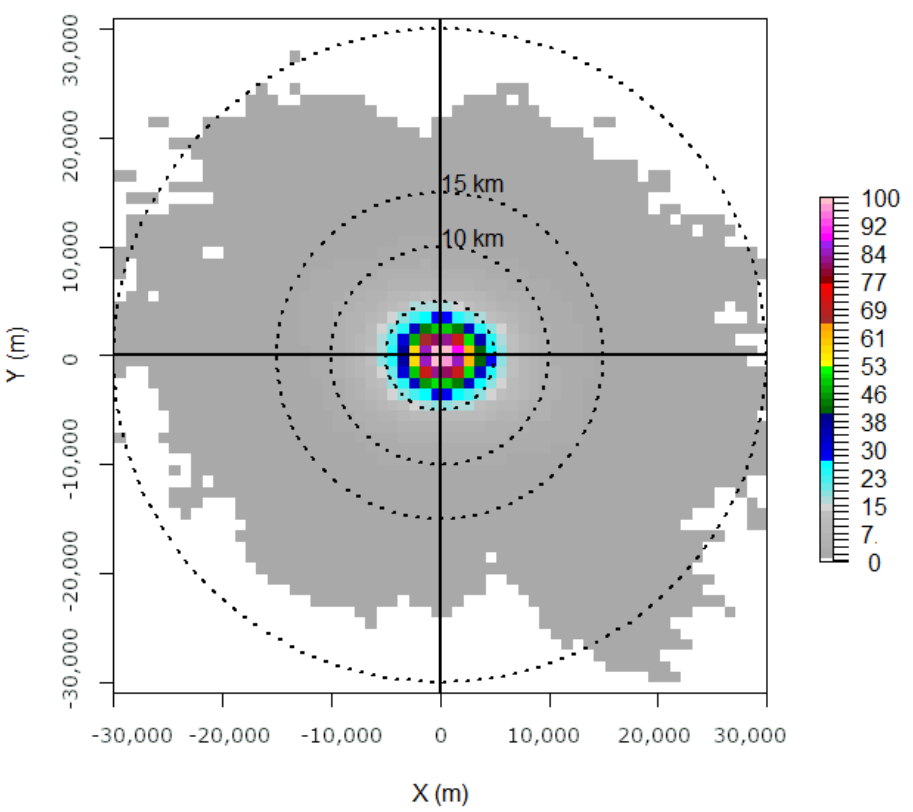
Figure 7. The probability of occurrence of hail is based on the 2196 cases of hailfall identified with VIL fields and centered on the centroids of all